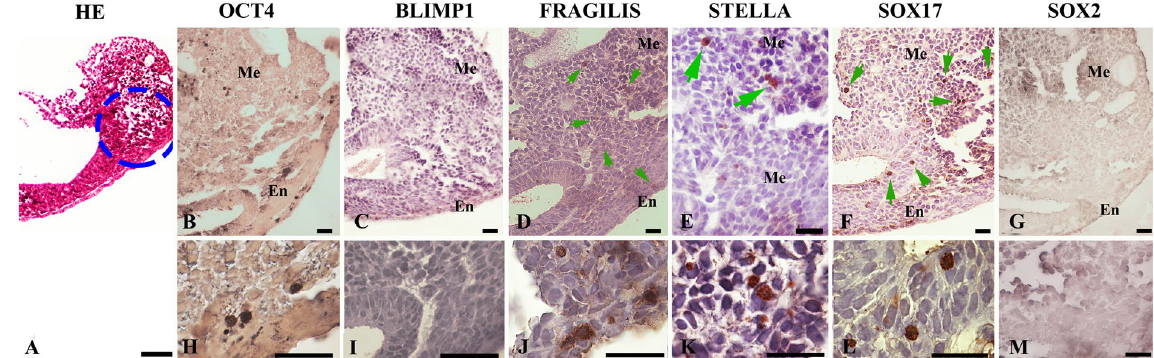
Figure 3. Germ line marker expression in the neural plate stage of the Lagostomus maximus embryo. ( A ) Hematoxylin-eosin (HE) stained general view of the neural plate stage; blue dotted-circle indicates immunoreactive areas in which markers were found. ( B ) OCT4-, ( D ) FRAGILIS-, ( E ) STELLA- and ( F ) SOX17- expressing cells in the base of the allantois in the ectoderm and mesoderm after gastrulation in the neural plate stage. ( C , I ) BLIMP1 and ( G , M ) SOX2 were not detected. ( H – M ) Details of the mesoderm area of the upper plate for each marker showing a higher magnification of presumptive PGC precursor cells positive for ( H ) OCT4, ( J ) FRAGILIS, ( K ) STELLA and ( L ) SOX17 and negative for ( I ) BLIMP1 and ( M ) SOX2. Me: mesoderm; En: endoderm. Scale bar: 20 µ m ( B–D,F,G ); 40 µ m ( A , E , M ); 1,000 µ m ( H – L ).